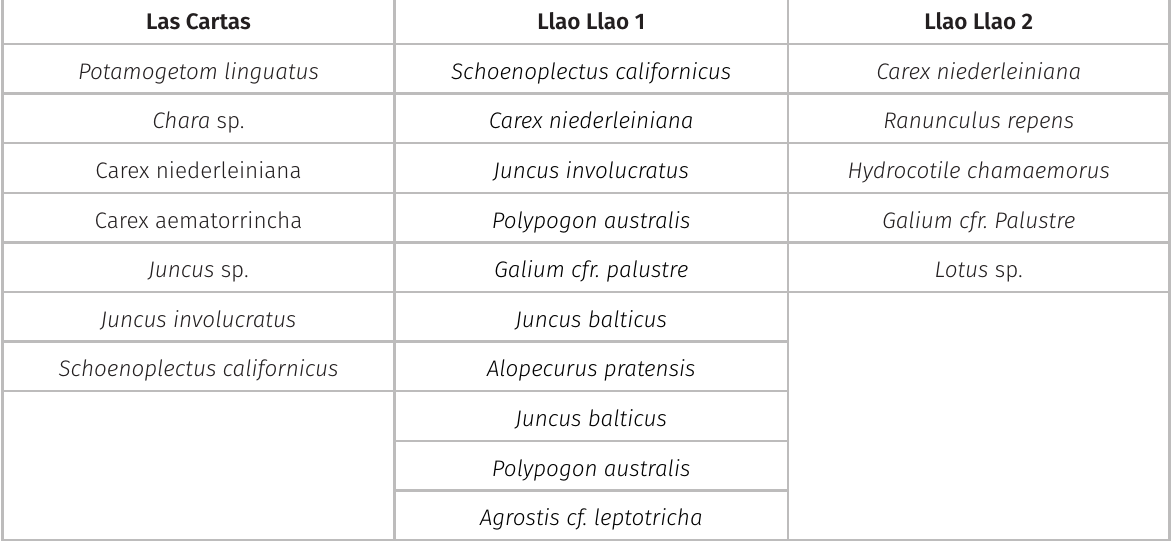
Larva. Length 17-18 mm (n=4). Sclerotized parts of the body reddish-brown, covered by erect, strong setae. Head. Oval in dorsal view, coloration reddish- brown, with characteristic pattern of yellow and fuscous maculae, muscle scars darkly marginated; in lateral view 1.2x longer than high, dorsal and ventral margins straight, stemmata surrounded by a pale area; chaetotaxy typical for the genus, setae 9 and 15 very long (2/3 and 1x the length of the head respectively) (Figs. 2a-d). Frontoclypear apotome spatula-like, mesolateral notches very pronounced, anterior margin straight, dark, with a yellowish, hourglass shaped macula mesally (Figs. 2a, b), fronto-clypeal ratio= 0.5 (as defined by Angrisano 1983), in lateral view frontal area almost flat (Fig. 2d). Labrum rectangular, lateral margins straight, anterior edge rounded with a mesal cleft, chaetotaxy typical for genus (Fig. 2e). Mandibles symmetrical, each with an internal tuft of setae and 4 apical teeth (Fig. 2f). Anterior ventral apotome triangular, 2/3x the length of ventral ecdisyal line, anterior margin straight and produced laterally, posterior end produced